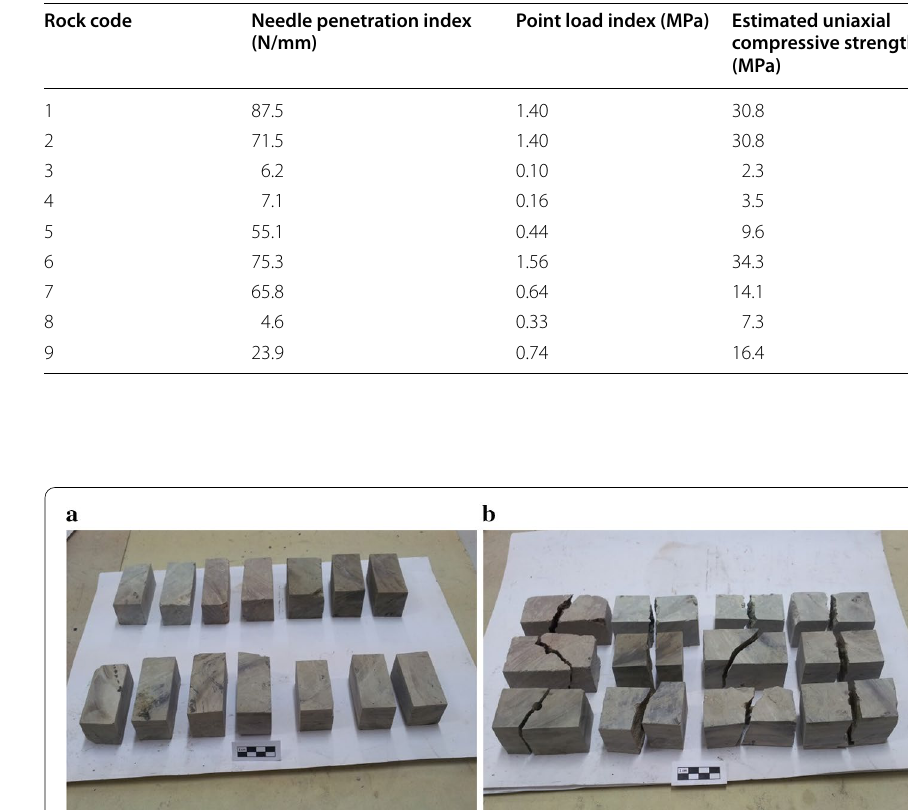
Table 3 Needle penetration index, point load index and estimated uniaxial compressive strength values